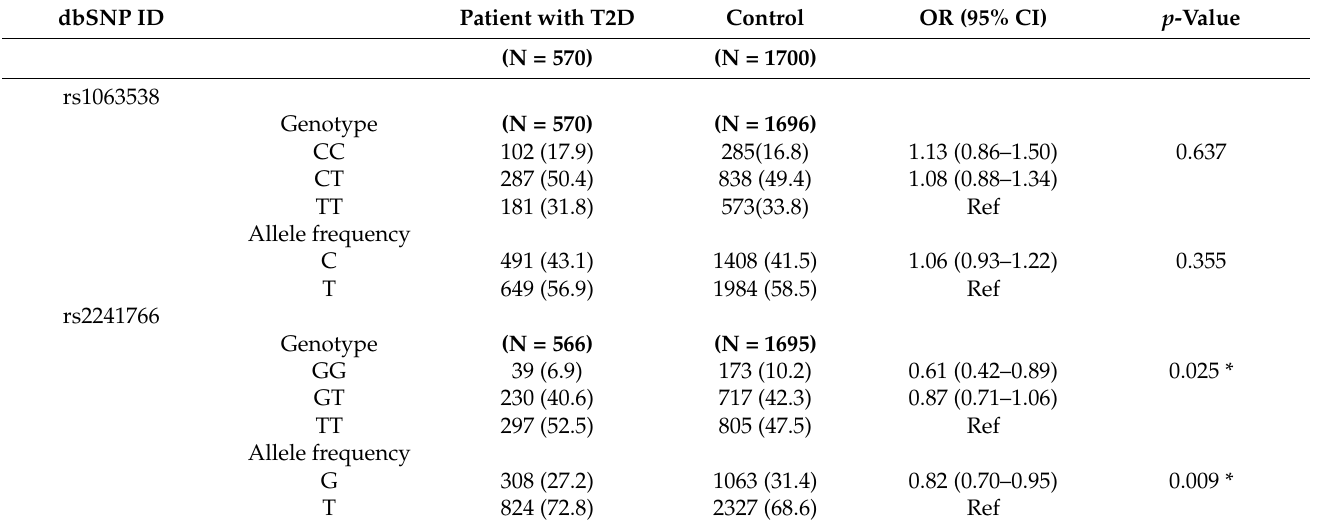
Figure 3. Map of adiponectin (rs1063538 and rs2241766) single-nucleotide polymorphisms (SNPs) located at chromosome region 3q27.3. Table 1. Genotypic and allelic frequencies of Adiponectin genetic polymorphisms in the patients with T2D and controls.